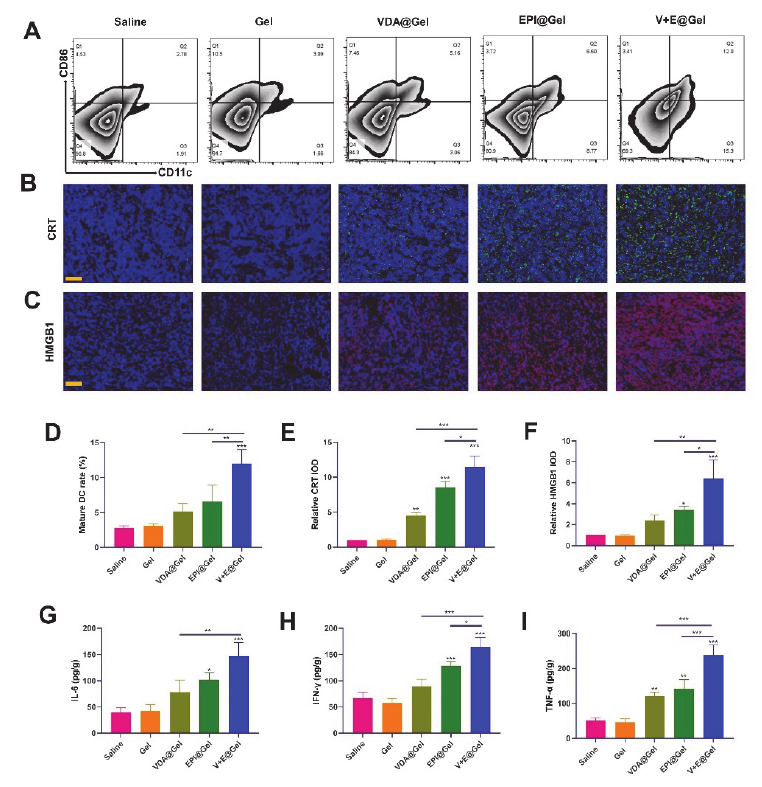
Figure 4. V+E@Gel activated the immunogenic cell death. ( A ) Flow cytometric analysis of infiltrated lymphocytes in tumor-draining lymph nodes; Immunofluorescence analysis of ( B ) CRT and ( C ) HMGB1 expression in tumor tissues from each treatment group, scale bar = 50 μ m. ( D ) Quantitative analysis of mature DC cells in tumor tissues from each treatment group. Semi-quantitative analysis of ( E ) CRT and ( F ) HMGB1 expression in tumor tissues from each treatment group. Cytokine levels, including ( G ) IL-6, (H) IFN- γ and ( I ) TNF- α in tumor tissues from each treatment group. All data are shown as mean ± S.D. ( n = 3), * p < 0.05, ** p < 0.01, and *** p < 0.001 vs. Saline. The specific immune response and the tumor immune microenvironment in tumor tissues were further verified by flow cytometric analysis. As shown in Figure 5A,D CD8+ T-lymphocytes in tumor tissues from the V+E@Gel group increased by 1.3-fold in compar- ison with the saline group. Moreover, due to the regulation effect of CA4P on the tumor immune microenvironment, CD8+ T-lymphocytes in tumor tissues from the V+E@Gel group were 61% and 35% more than that from VDA@Gel, and EPI@Gel group, respec- tively. This phenomenon was further proved by the flow cytometric analysis of the sub- type of Treg and MDSCs cells. As indicated in Figure 5B,C,E,F, Treg and MDSCs cells in tumor tissues from the V+E@Gel group were both decreased by ~50% in comparison with the saline group, suggesting the immune surveillance in tumor tissues was effectively re- lieved. Further quantitative analysis of the number of total CD4+ and FOXP3+ CD4 T cells